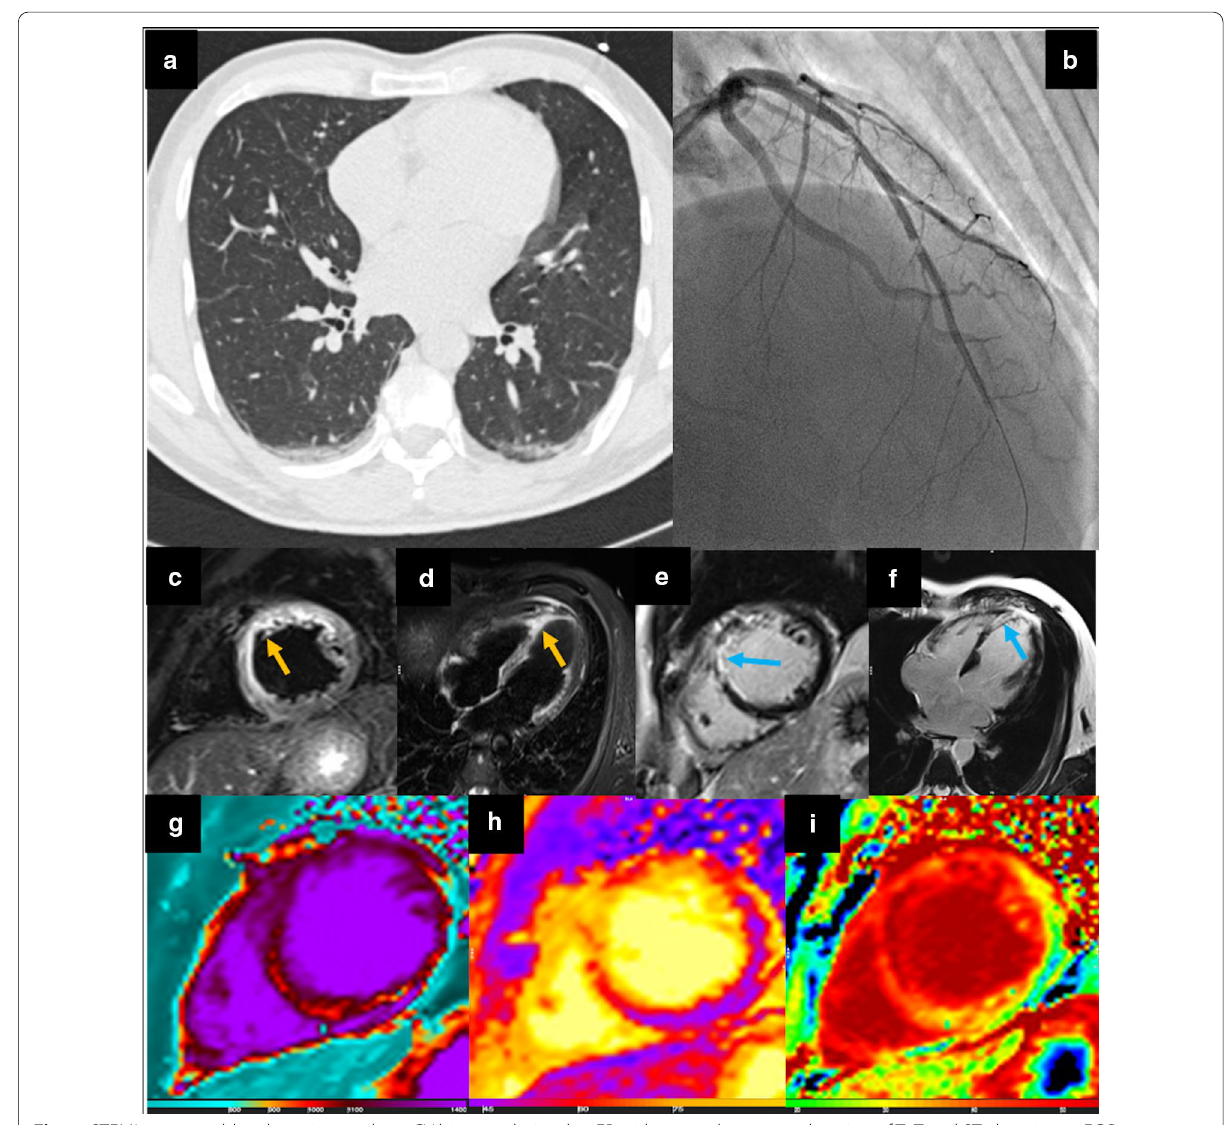
Fig. 5 STEMI. 45-year-old male patient with no CV history admitted to ER with acute chest pain, elevation of TnT and ST elevation at ECG. Nasopharyngeal swab tested positive for SARS-CoV-2 and chest CT showed a mild pulmonary involvement ( a ). Occlusion of proximal DA was detected and treated at ICA ( b ). CMR, performed 7 days after revascularization, showed antero-septal edema of mid and apical planes at STIR images ( c , d orange arrows). LGE sequences evidenced necrosis with subendocardial distribution on antero-septal segments and transmural extension on anterior segments on mid planes ( e , f blue arrows). Increased values of native T1 ( g ), T2 mapping ( h ) and ECV fraction ( i ) confirmed the presence of edema and necrosis on anterior and antero-septal segments on mid and apical planes. CV cardiovascular; ER emergency room; TnT t-troponin; CT computed tomography; DA descending coronary artery; ICA invasive coronary angiography; CMR cardiac magnetic resonance; STIR short tau inversion recovery; LGE late gadolinium enhancement, ECV extracellular